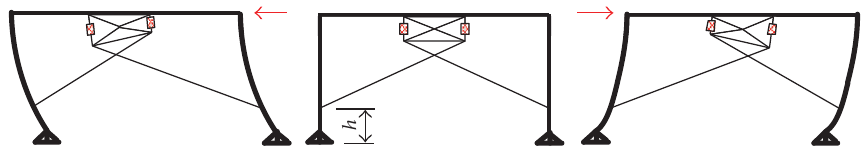
Figure 9: Mechanism of the control system with AFDs.